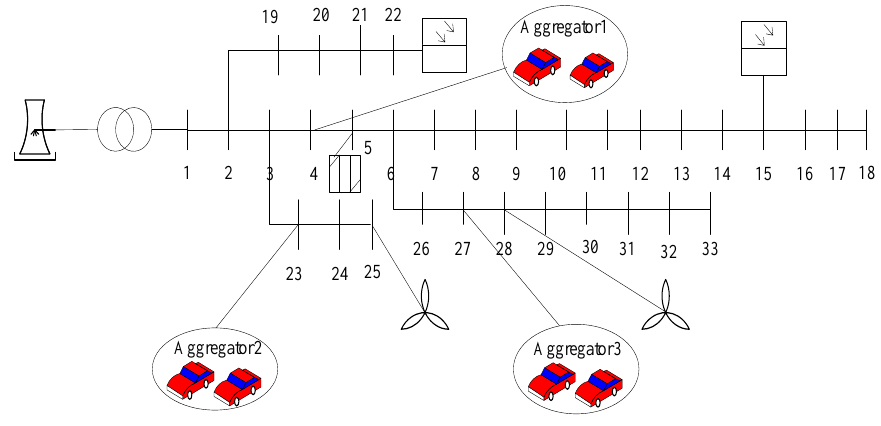
Figure 2. IEEE33 node in the modify test system.